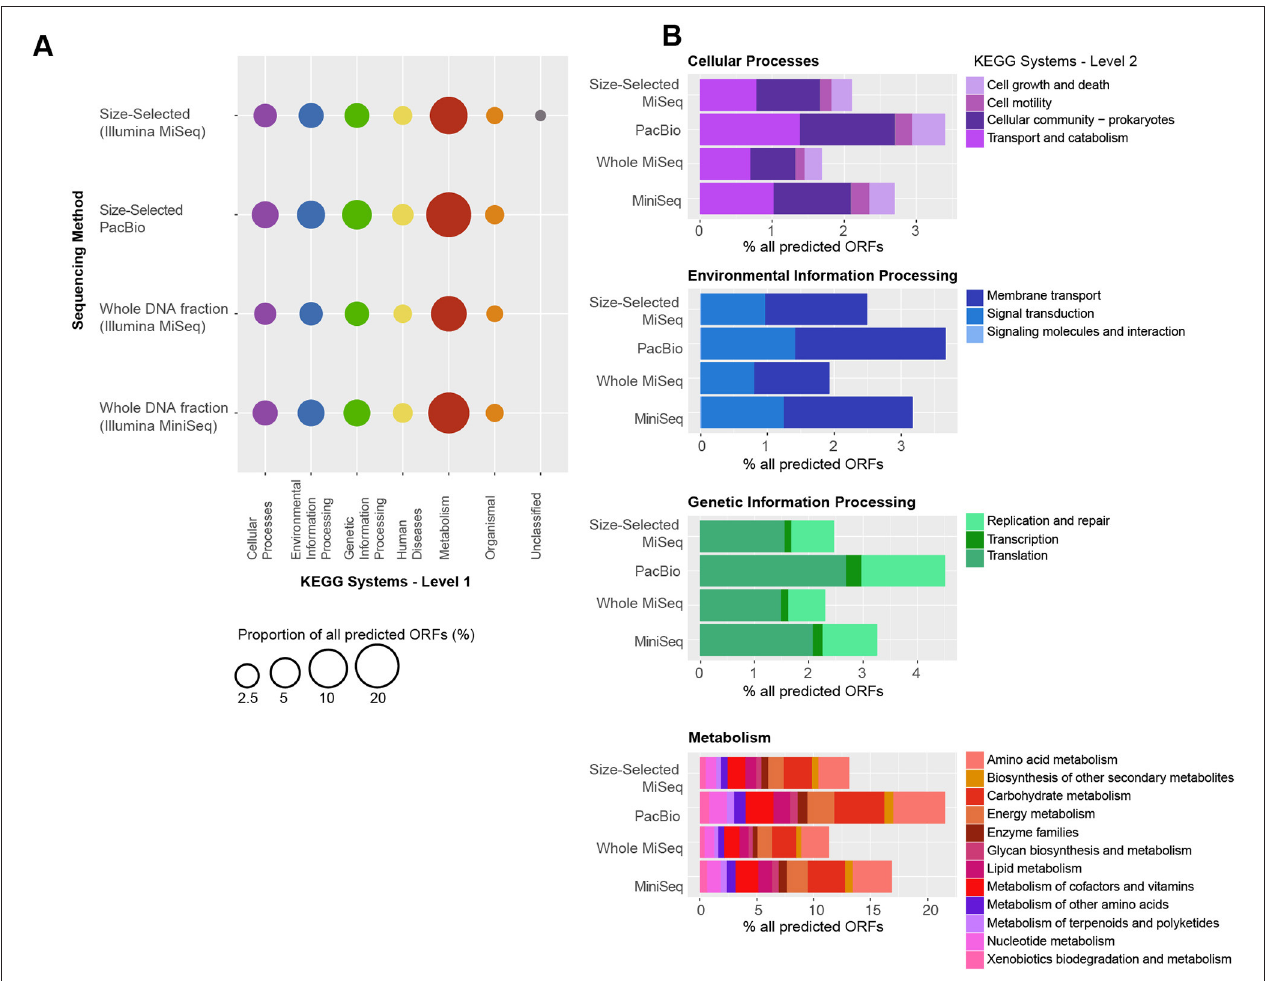
FIGURE 6 | Functional gene distribution, as a percent of all the predicted genes in each sequencing dataset. (A) The KEGG systems are indicated on the x-axis, and the sequencing approach is shown on the y-axis. Many genes mapped to more than one function and to more than one category. All genes mapping to “Organismal” and “Human Diseases” also mapped to other systems, including “Metabolism,” “Genetic Information Processing” and “Cellular Processes.” A full list of KO numbers and their KEGG system assignments is provided in the supplement. (B) Distribution of KEGG subsystems for “Cellular Processes,” “Environmental Information Processing,” “Genetic Information Processing,” and “Metabolism.” In each case, the y-axis is the same as in (A) and the percent of the total genes in each KEGG subsystems is indicated by the